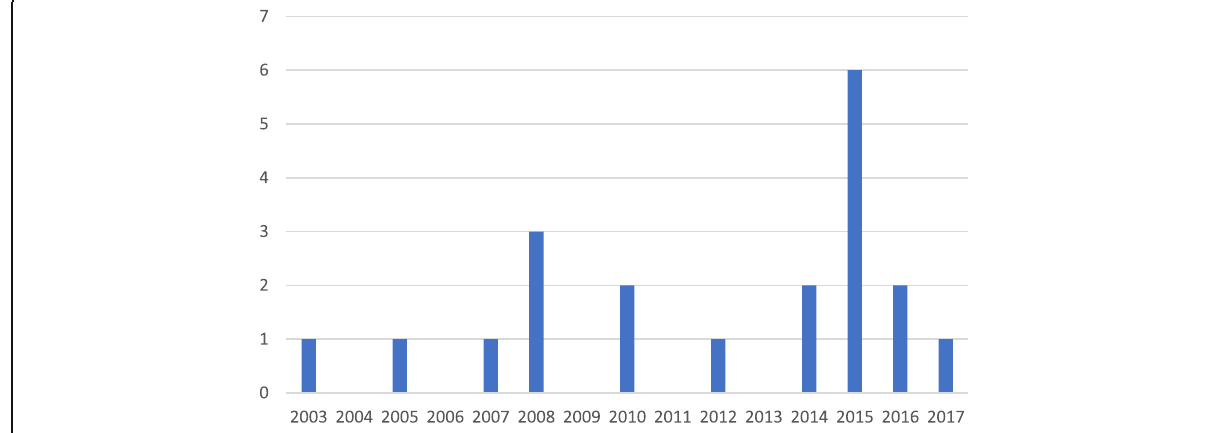
Fig. 3 Distribution of studies included in the review by